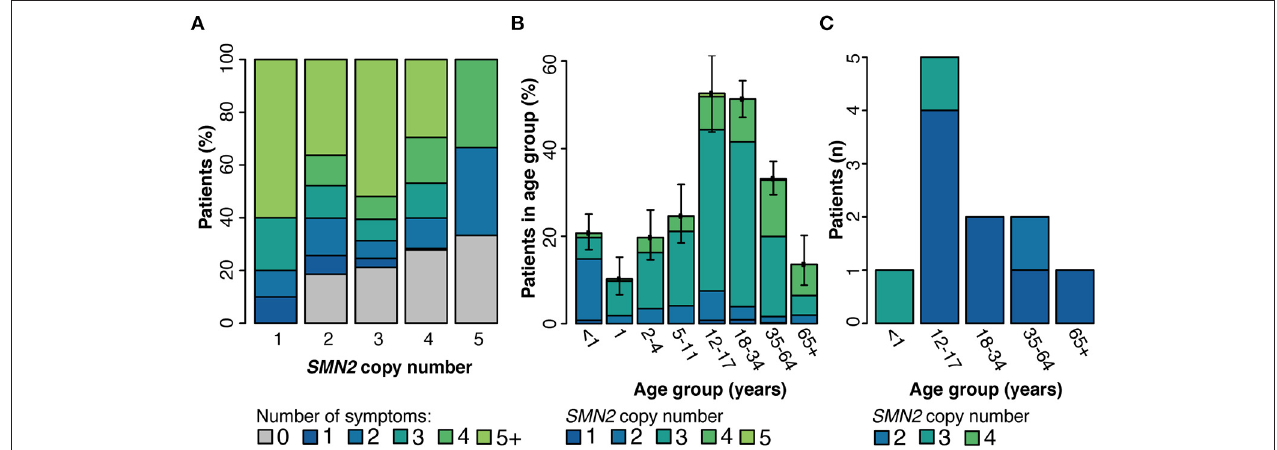
FIGURE 4 | Genetic modifiers of SMA. Among individuals with a positive molecular diagnosis who underwent testing through the SMA Identified Program, the number of clinician-reported symptoms (A) and age distribution (B) were reported by SMN2 copy number. (C) Among all individuals with a positive diagnosis who were tested through Invitae (SMA Identified or outside of the program), those with the SMN2 c.859G > C variant were stratified by age at time of testing and SMN2 copy number. 95% confidence intervals for every subgroup in panels (A,B) are reported in Supplementary Tables 3 , 4